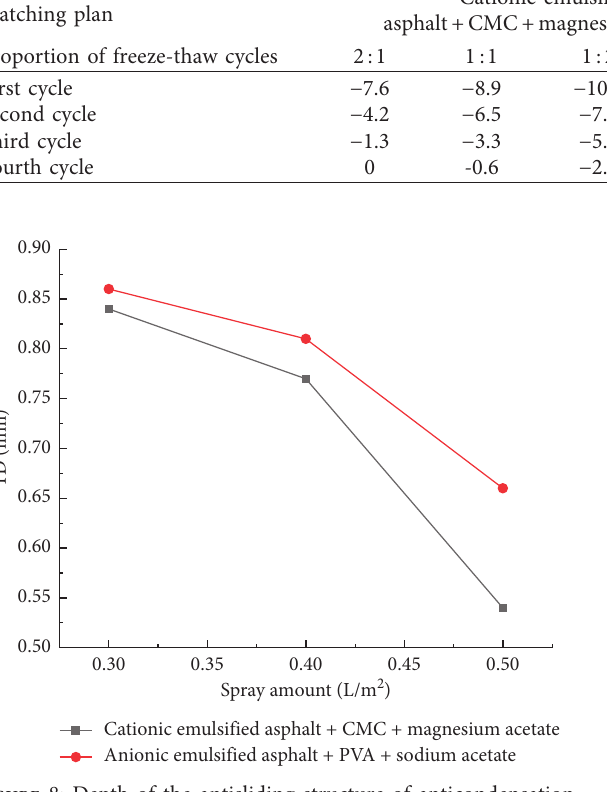
Figure 8: Depth of the antisliding structure of anticondensation ice-melting mist seal under different spraying